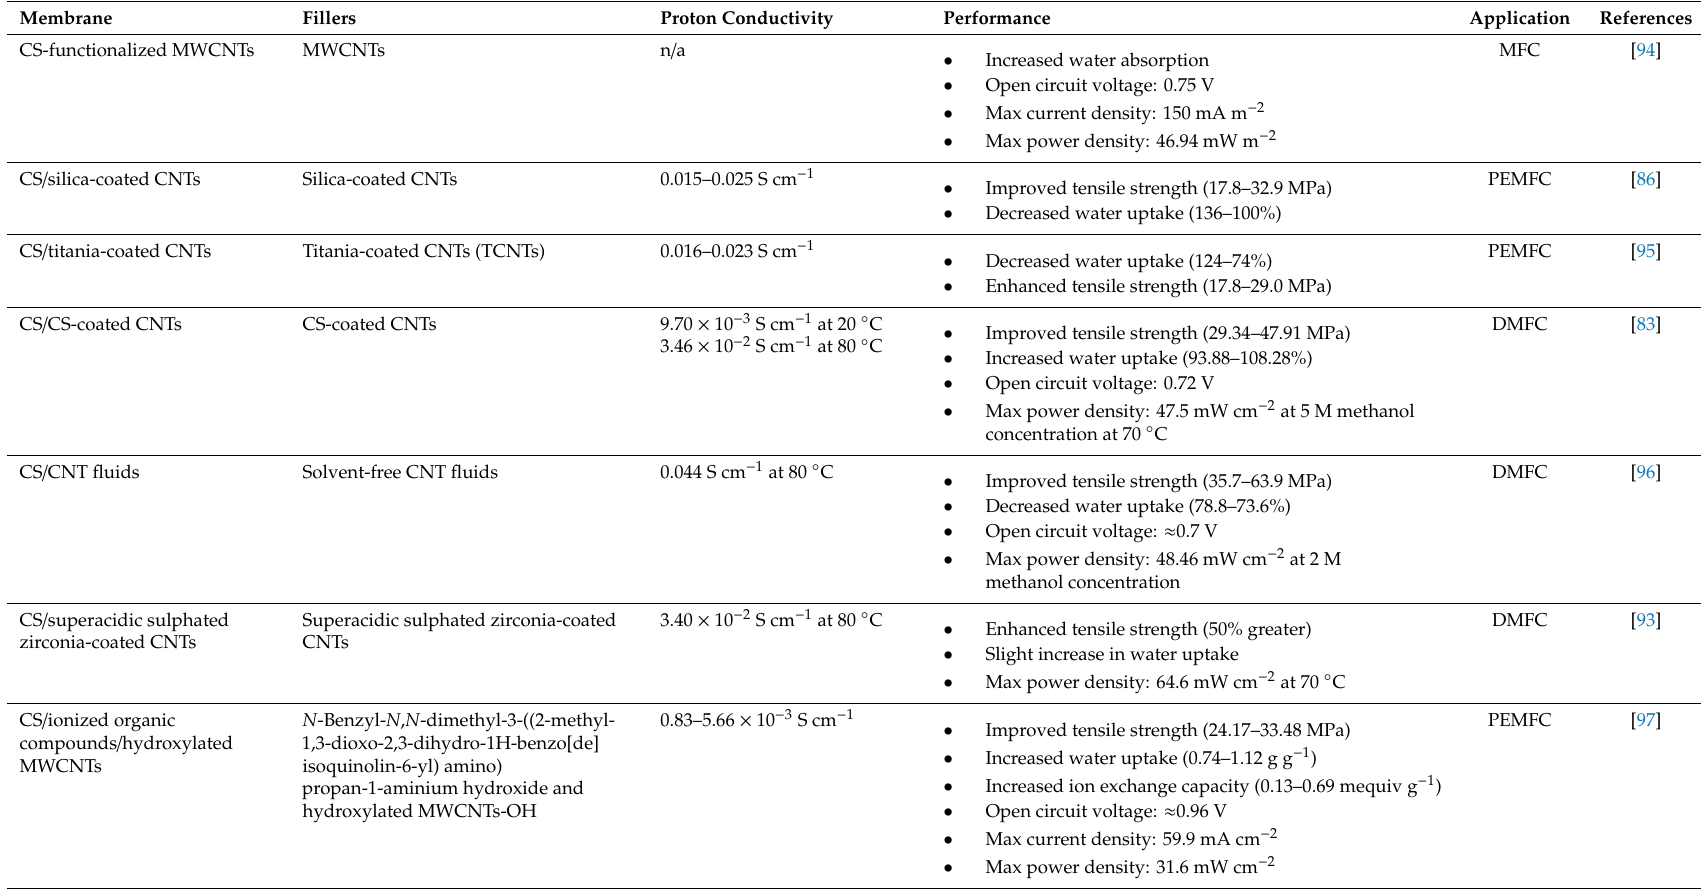
Table 3. Applications of carbon nanotubes (CNTs) in CS hybrid